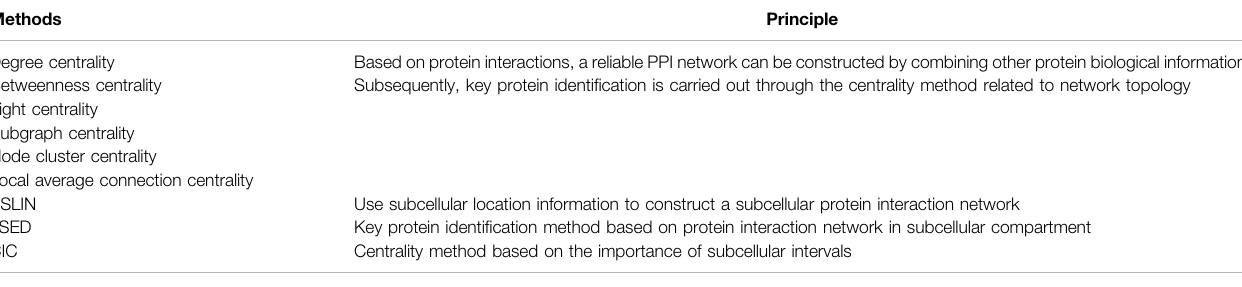
TABLE 1 | Key protein identi fi cation methods. Methods